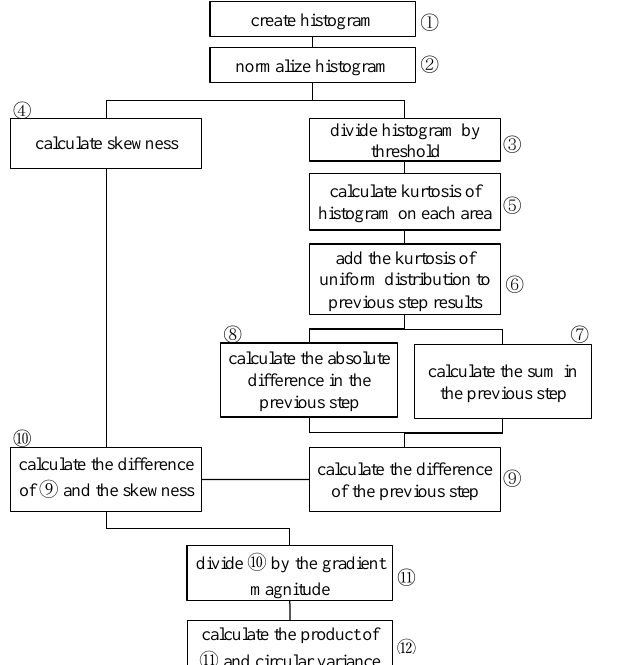
Figure 8. Evaluation feature types